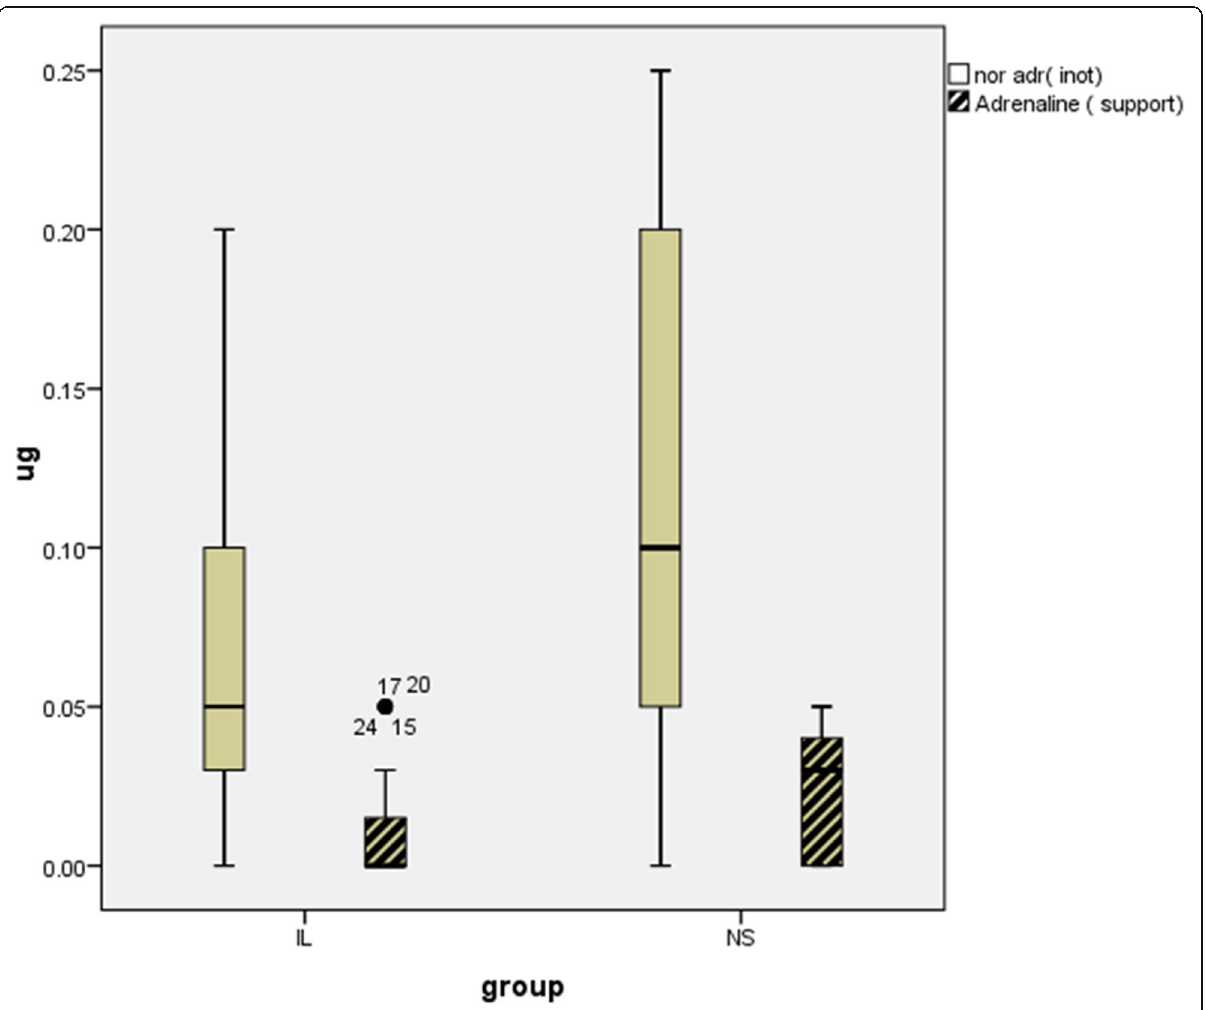
Fig. 1 Types and doses of inotropes. The middle black solid line represents the median, the upper and lower margins of each box are the IQR, whiskers are maximum and minimum values, and dot represent the number of patient with outlier data. Data are presented as mean ± SD. * P value < 0.001 is considered statistically